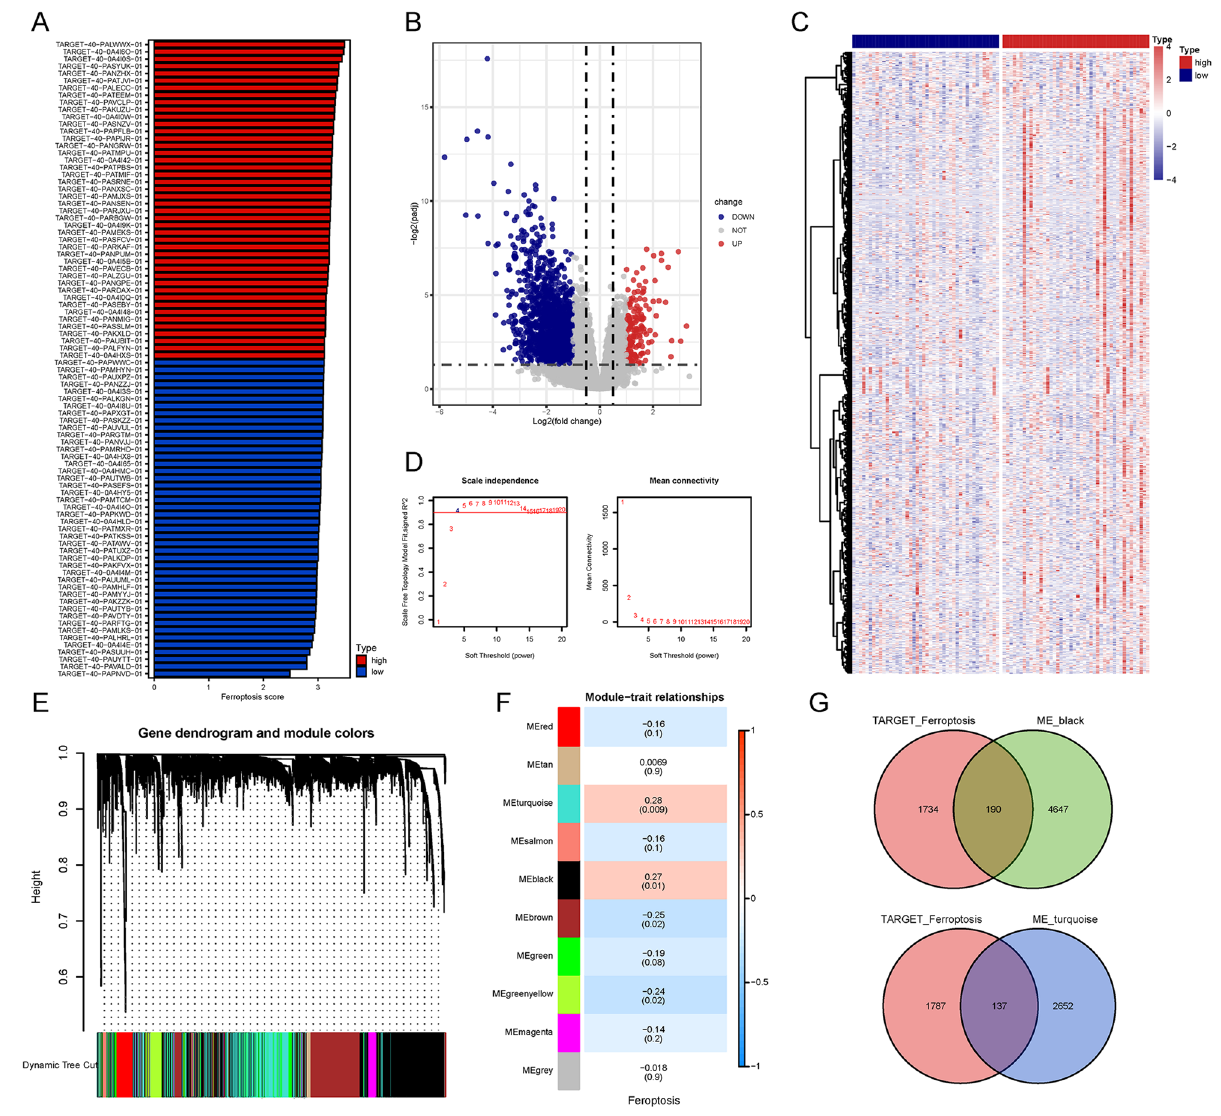
Figure 2. Verification of ferroptosis candidate genes based on the TARGET-OS dataset. ( A ) Overview of the association degree between samples and ferroptosis score from high to low ranking. ( B , C ) Volcano plots and heatmaps of differentially expressed genes (DEGs) according to high and low ferroptosis scores. ( D ) Analysis of scale-free fit parameter and mean connectivity for different soft-thresholding power. ( E , F ) Dendrograms and heatmaps showing gene modules associated with the ferroptosis score. In Fig. 2F, the p values and correlation values are shown inside and outside the brackets, respectively. ( G ) Venn diagram representing the intersection of genes within the black and turquoise modules, which denote ferroptosis-related genes and DEGs,